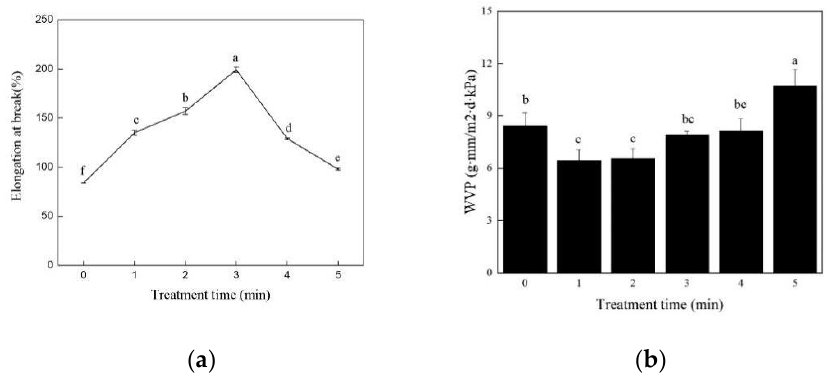
Figure 5. Effects of different ACP treatment times on elongation at break and WVP of the soy protein film. ( a ) Elongation at break; ( b ) WVP. Different lowercase letters denote significant differences ( p < 0.05).